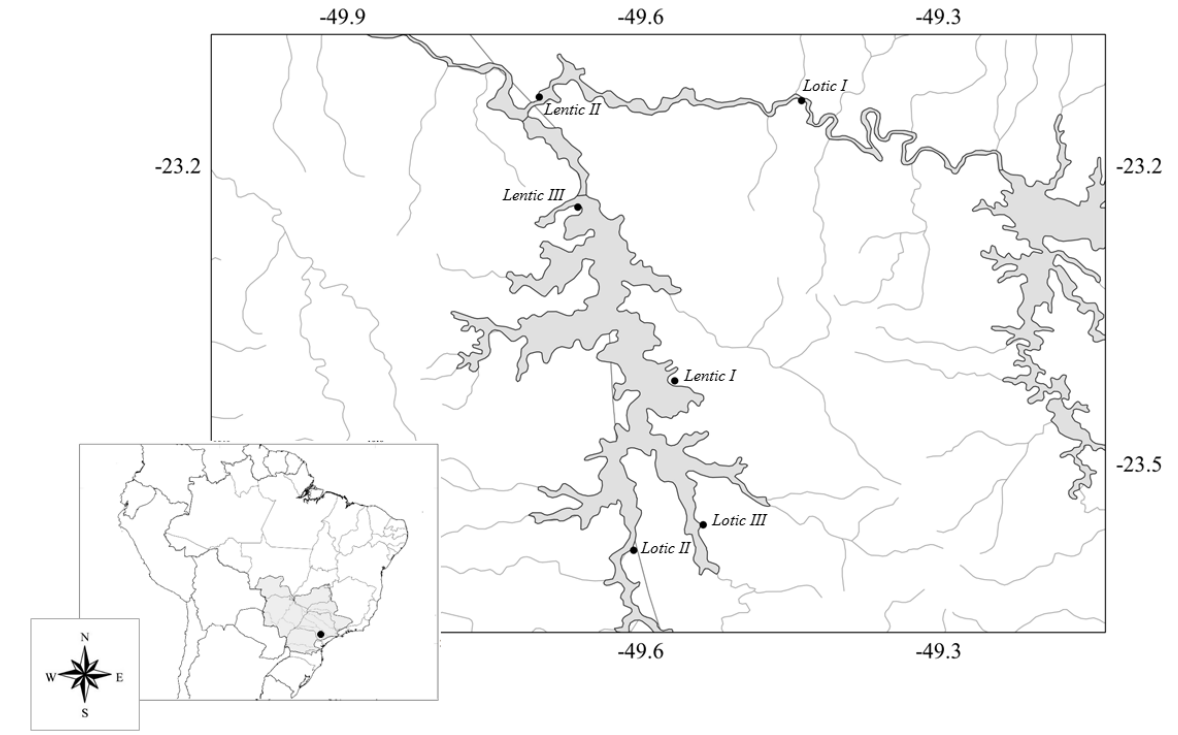
Figure 1. Map of the study area, indicating the Chavantes Reservoir and its